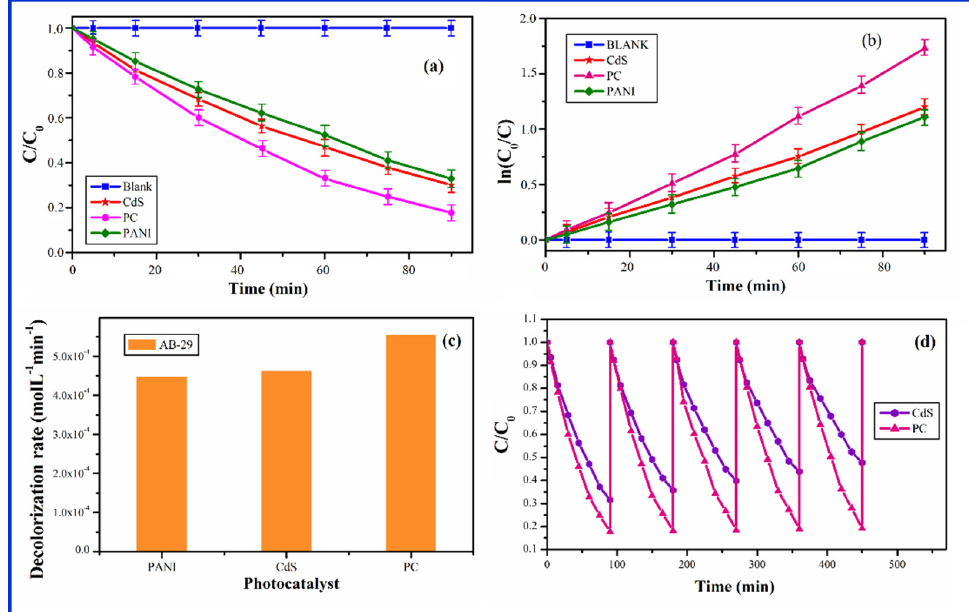
Figure 9. ( a ) Change in concentration of AB-29 with time in the presence and absence of PC in comparison to PANI and CdS nanoparticles. ( b ) Change in concentration of AB-29 with time in the presence and absence of PC in comparison to PANI and CdS nanoparticles. ( c ) The decolorization rate of AB-29 in the presence of synthesized PC in comparison to PANI and CdS nanoparticles. ( d ) Stability and recycle of PC in comparison to pure CdS.